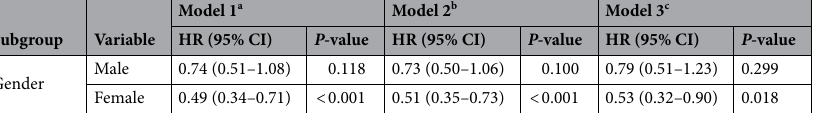
Table 4. Association of prior thyroid cancer with the risk of PLC-specific death among PLC patients by gender. PLC primary liver cancer, HR hazard ratio, CI confidence interval. a Model 1 was established as a crude model without adjustment. b Model 2 adjusted for age (or and gender). c Model 3 adjusted for age, (or and gender), race, marital status, tumor size, regional nodes positive, primary site, histology groupings, surgery, chemotherapy, histologic grade, AJCC T status, AJCC N status, AJCC M status, (or and SEER historic stage).